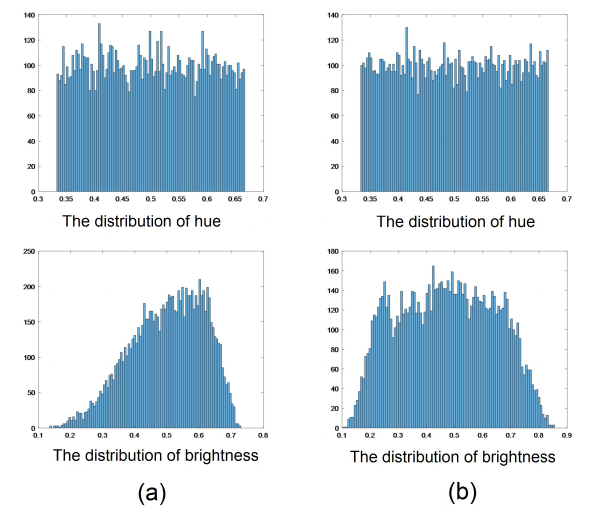
Figure 6. Hue and brightness distribution of global ambient light. ( a ) the ambient light generated using a uniform distribution; ( b ) the ambient light generated using the modified distribution (note that the value of green-blue hue is 0.33–0.66).